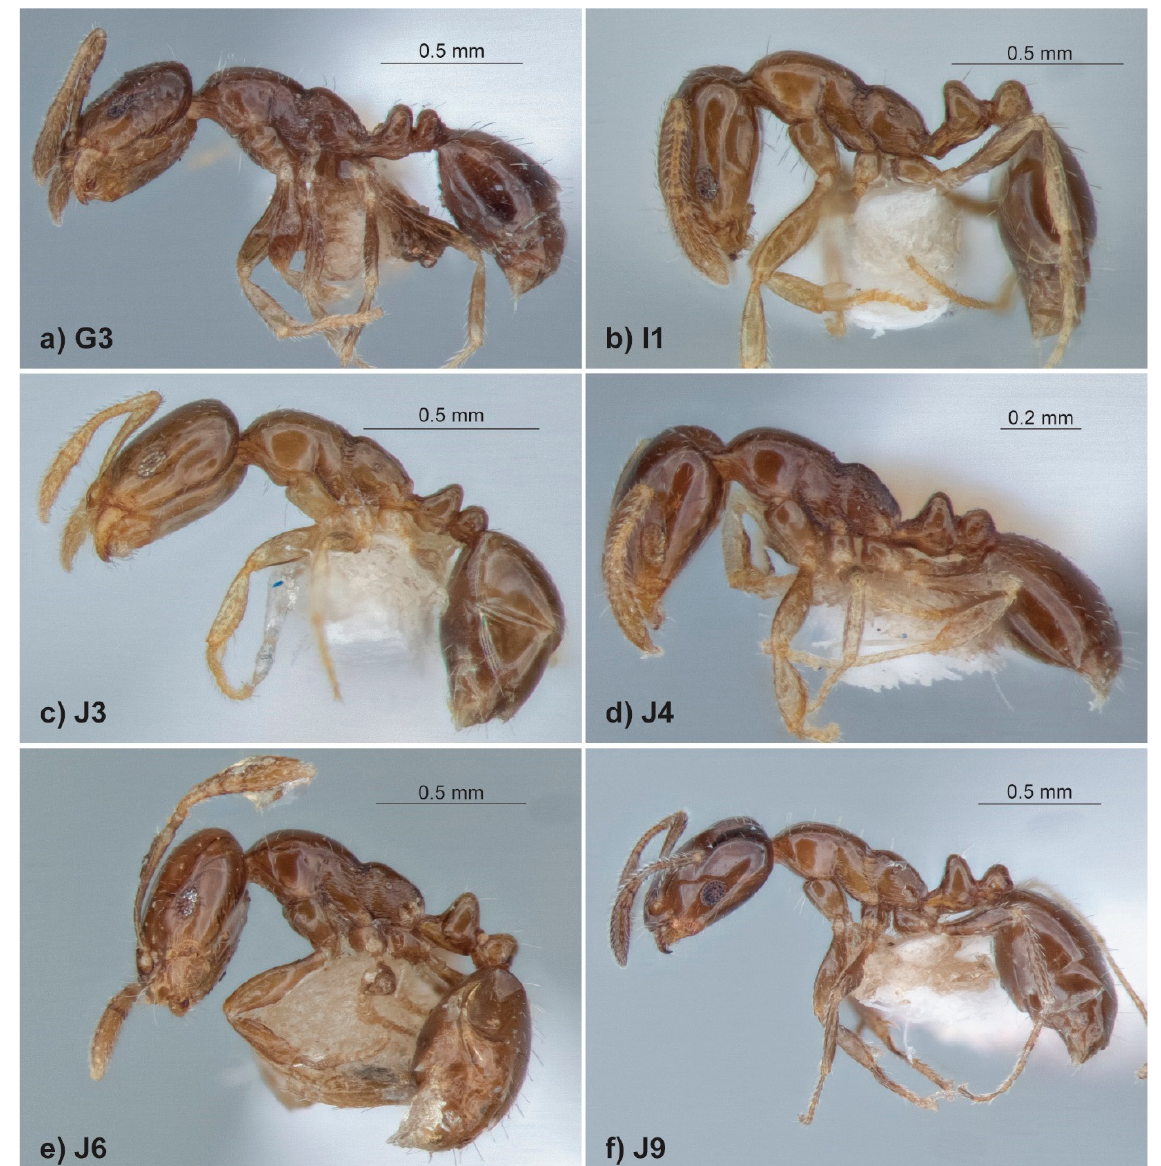
Figure 7. Images of species from the ‘sp. 14’ morphotype. ( a ) specimen MONM613-18; Mt Elizabeth, WA; ( b ) specimen DARW225-15; Currawarra Stm, Qld; ( c ) specimen MONO110-16; Claravale Stn, Qld; ( d ) specimen MONO111-16; Glendonnel Stn, Qld; ( e ) specimen MONO170-16; Jilbadji Nat Res, WA: ( f ) specimen DARW237-15; Eurardy Stn,